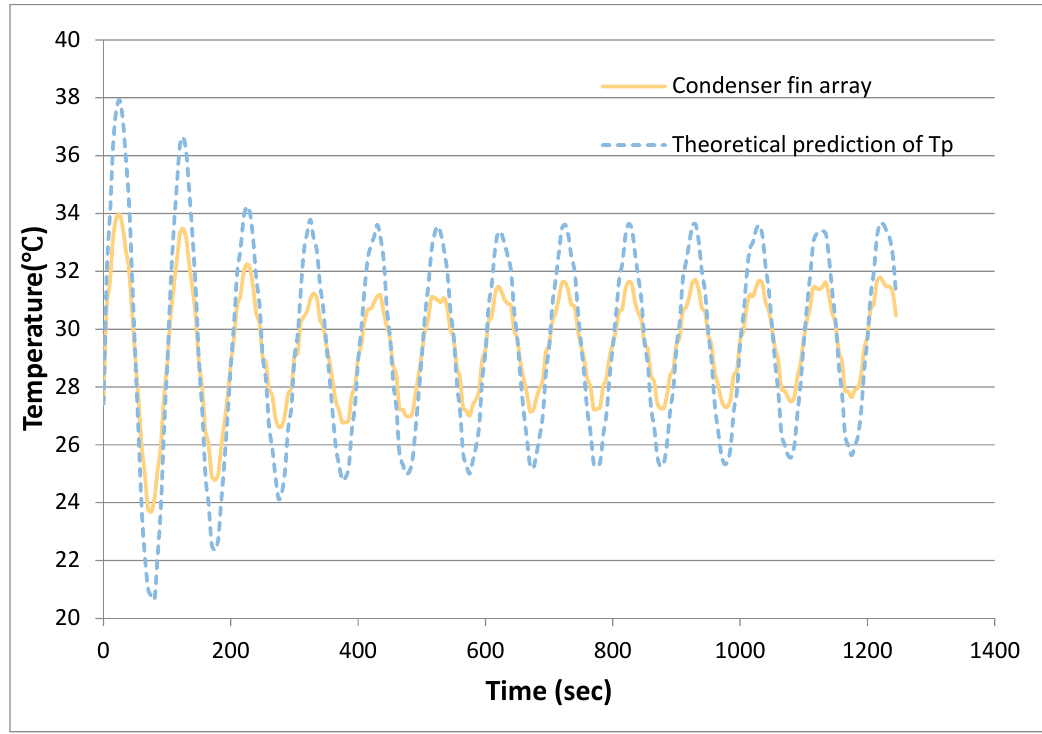
Figure 10. Condenser section temperature profiles of 0.01 Hz operation.